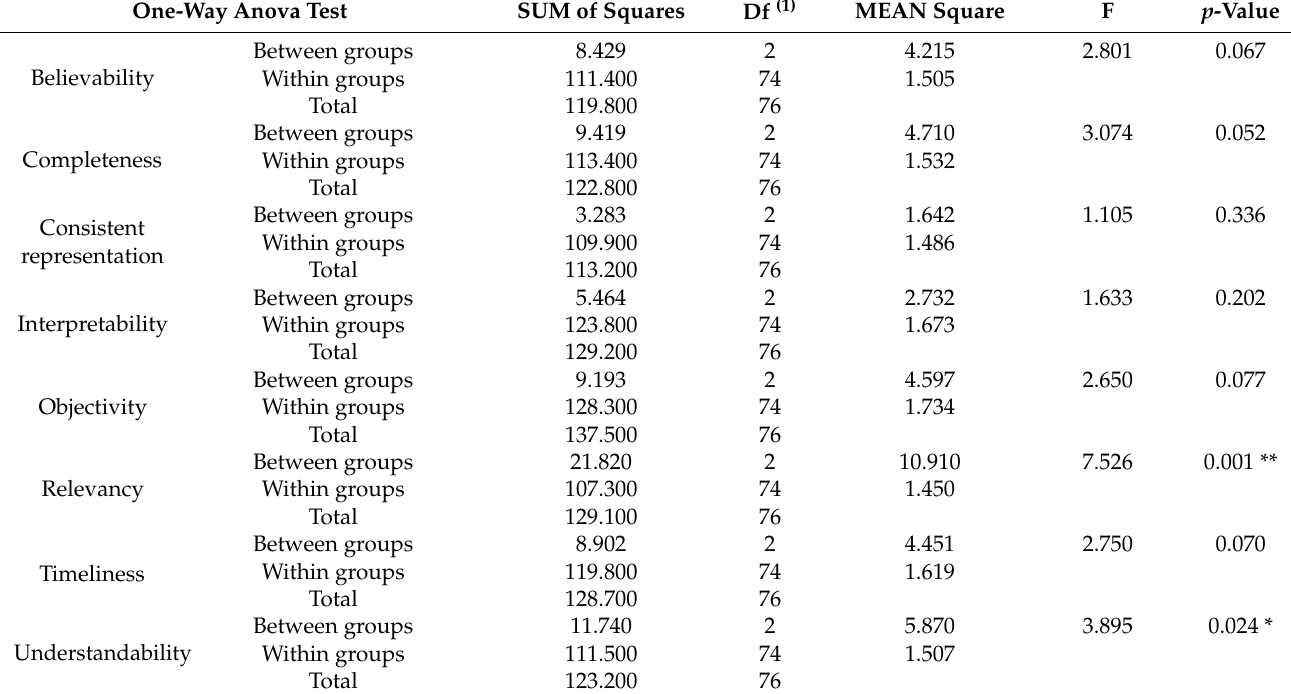
Table 6. Differences in information quality between knowledge groups.